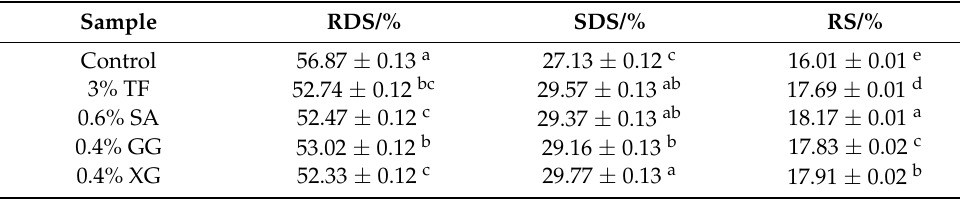
Table 3. Effect of TF, SA, GG and XG on in vitro digestibility of noodles.